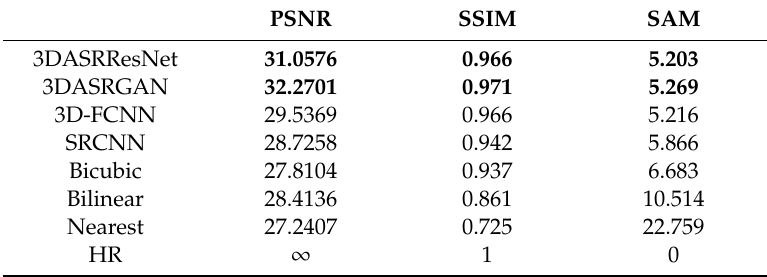
Table 1. Quantitative comparison results of di ff erent SR methods based on the Washington DC Mall dataset. PSNR SSIM SAM